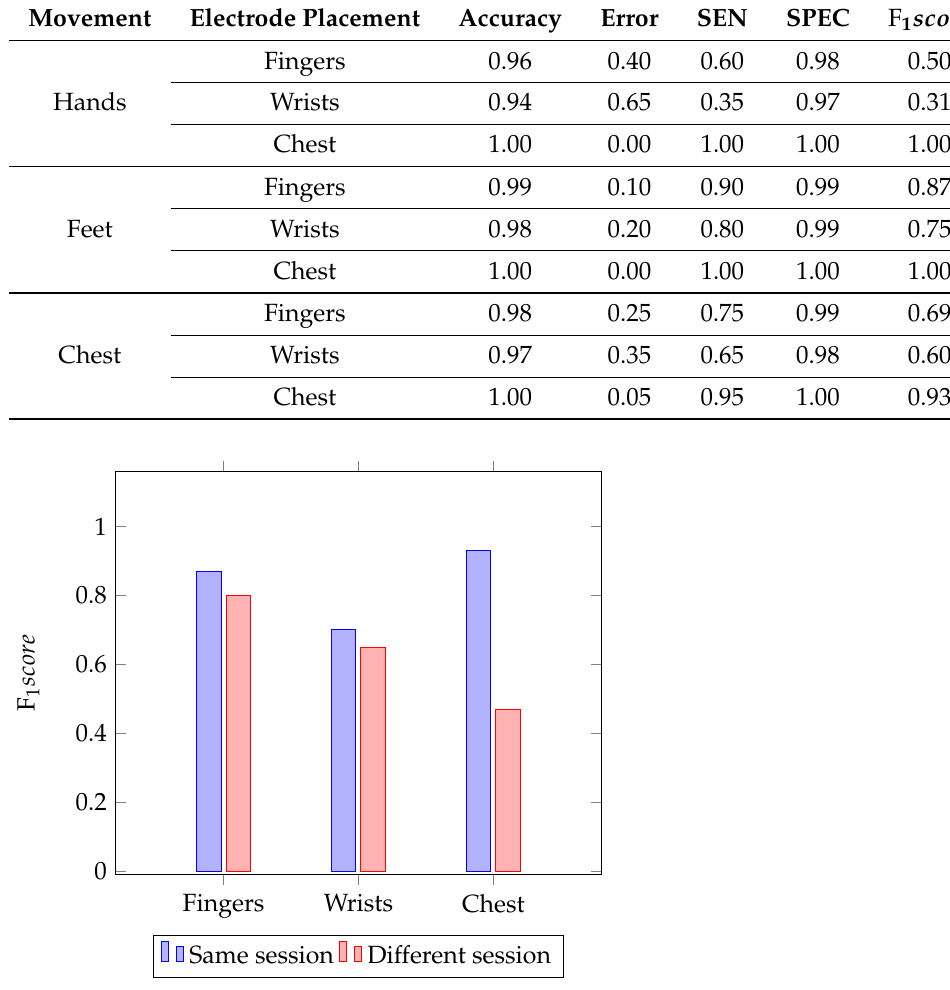
Figure 3. Histogram of the accuracy values, for the same and different sessions in every single